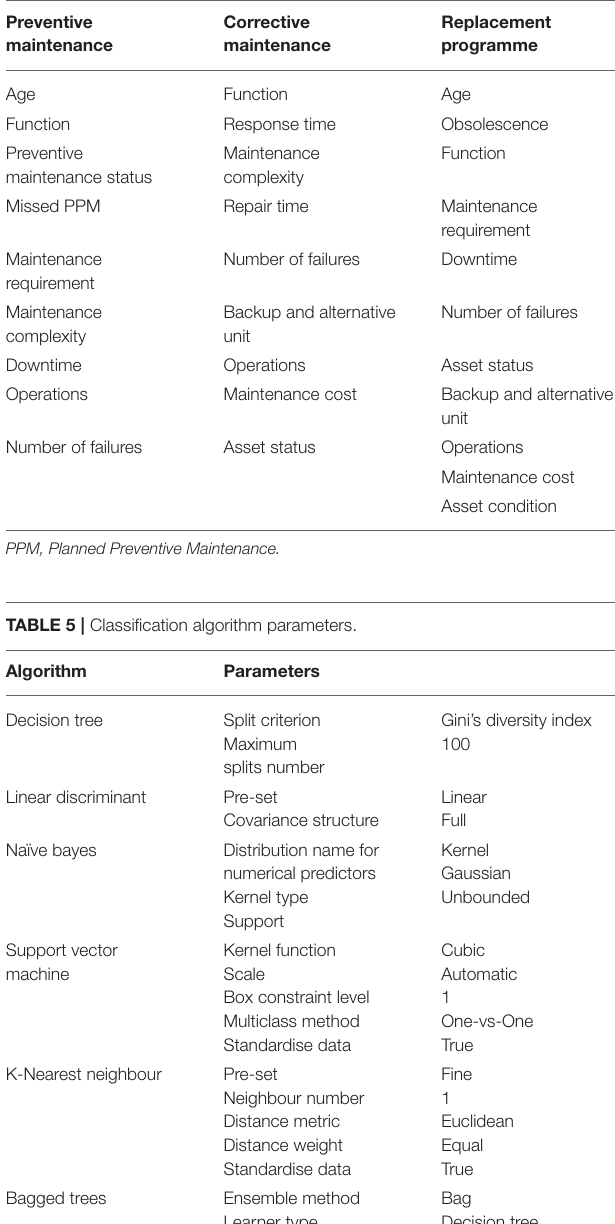
TABLE 4 | Features of medical equipment.